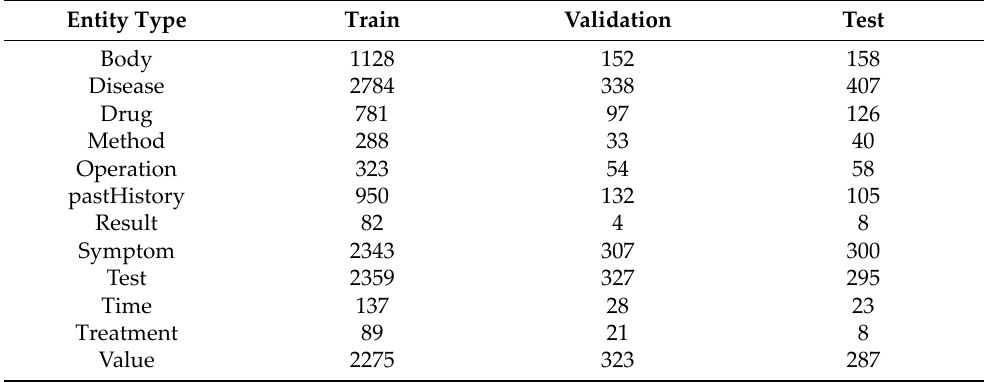
Table 2. Statistics on the number of dataset entities.